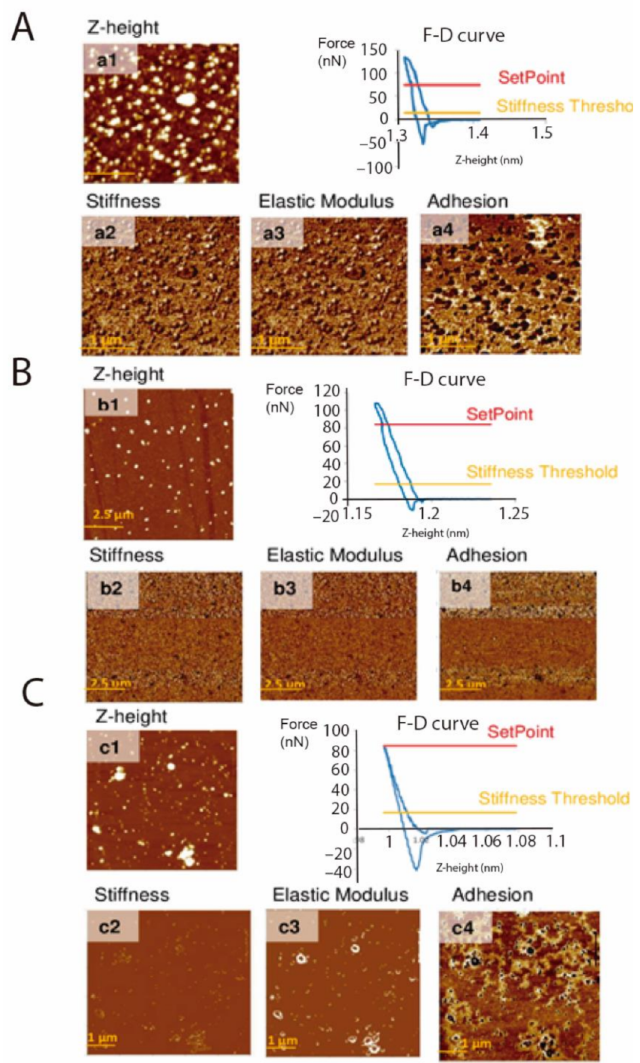
Figure 6. Atomic force microscopy Z-height images and nanomechanical maps showing stiffness, elastic modulus and adhesion profile of EVs of TCT ( A ), EVs of E ( B ) and EVs of TCT treated with proteinase K ( C